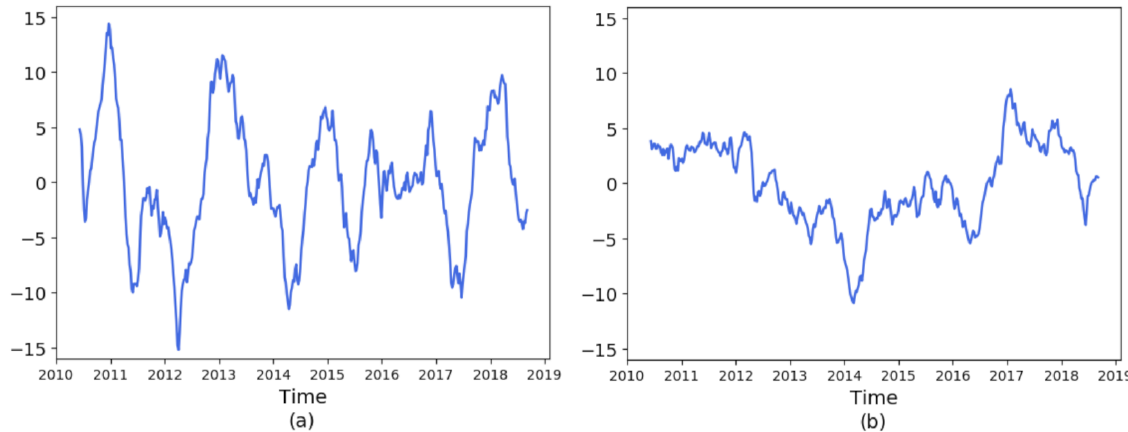
Figure 7. First ( a ) and second ( b ) time component of the weekly TWS